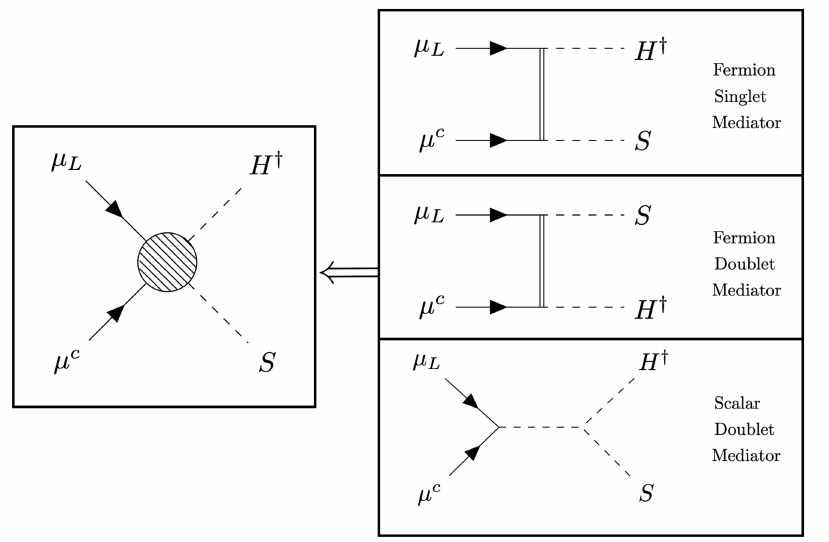
Figure 9 . The singlet scalar scenario requires a UV completion to generate the dimension-5 operator 1 SH † Lµ c (left), see eq. (2.8). There are three possibilities to generate this operator via tree-level Λ exchange of a mediator field, shown on the right. Assuming a minimal particle content for the additional fields, this corresponds to integrating out a fermion singlet ( t -channel), a fermion doublet ( t -channel), or a scalar doublet ( s